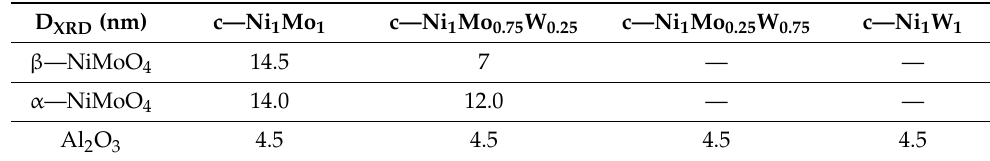
Table 1. Average values of D XRD of the studied